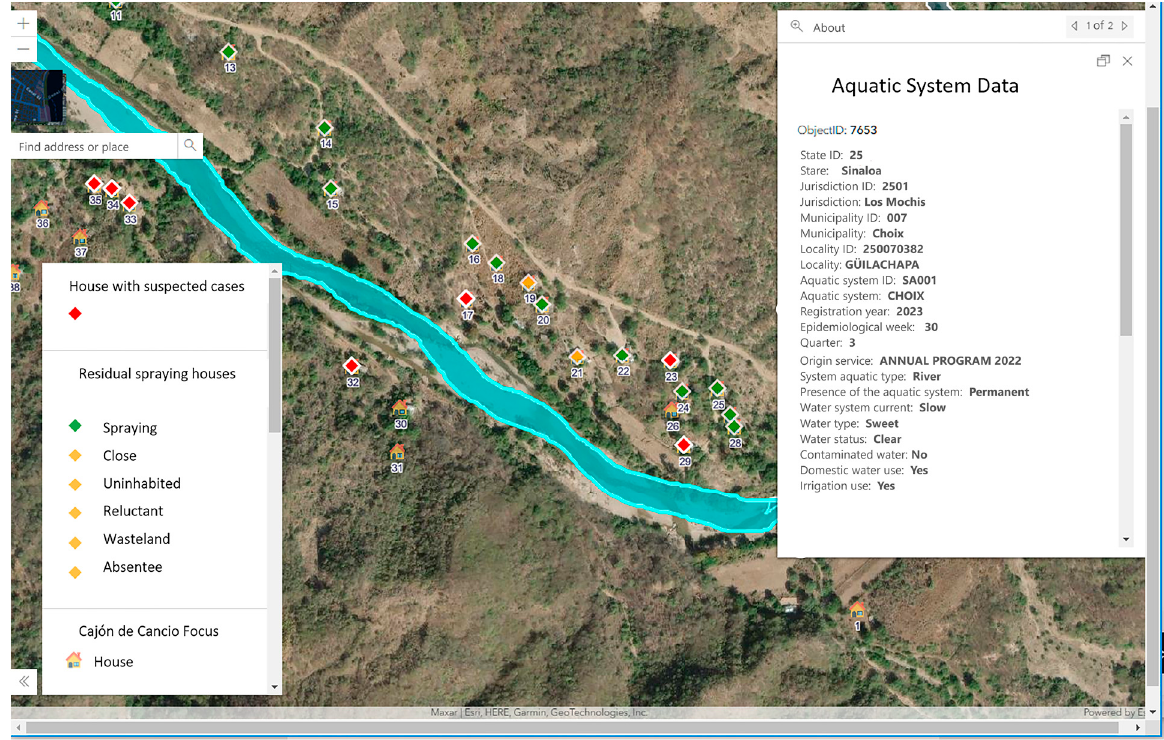
Figure 6. Geographic information system. Here is an example of a query, where the first layer contains epidemiological surveillance data, the second layer contains vector control data and the third layer shows the houses, these data layers are referred to the houses, that is why the unique identifier is shown in each of them. In addition, in the geographic viewer you can see the characteristics of the aquatic system .